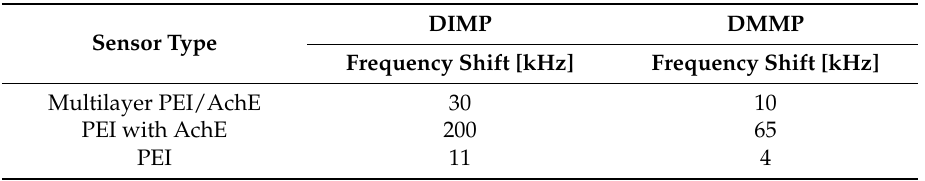
Table 2. Frequency shift of sensors at six-ppm dimethyl methylphosphonate (DMMP) concentration and five-ppm diisopropyl methylphosphonate (DIMP)